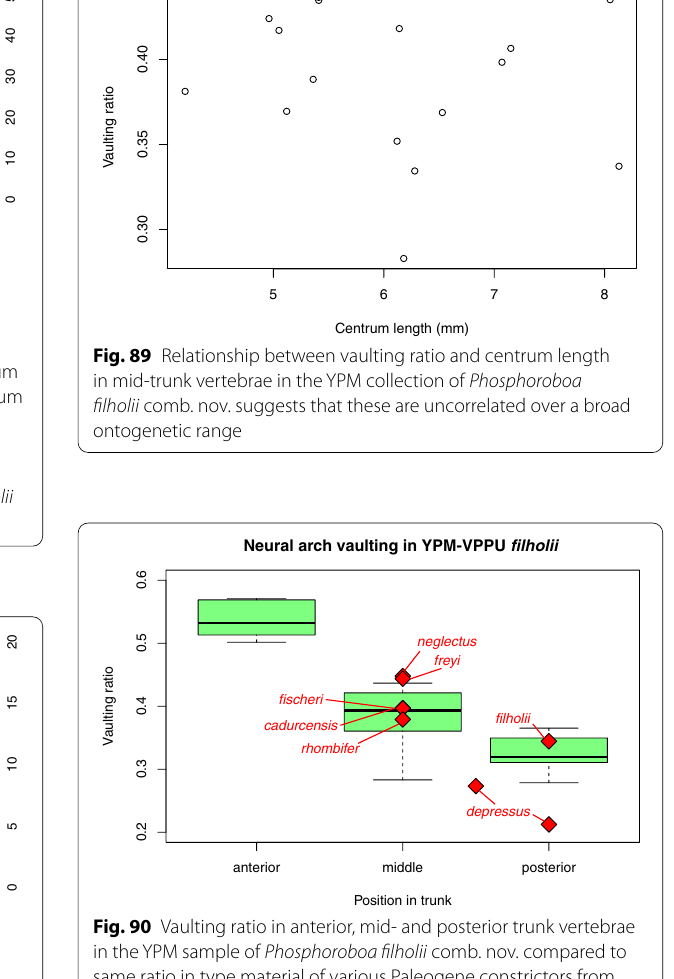
Fig. 88 Distribution of centrum length (CL) in YPM sample of Palaeopython cadurcensis , Phosphoroboa filholii comb. nov., and “ Palaeopython ” neglectus (frequency counts on right axis).